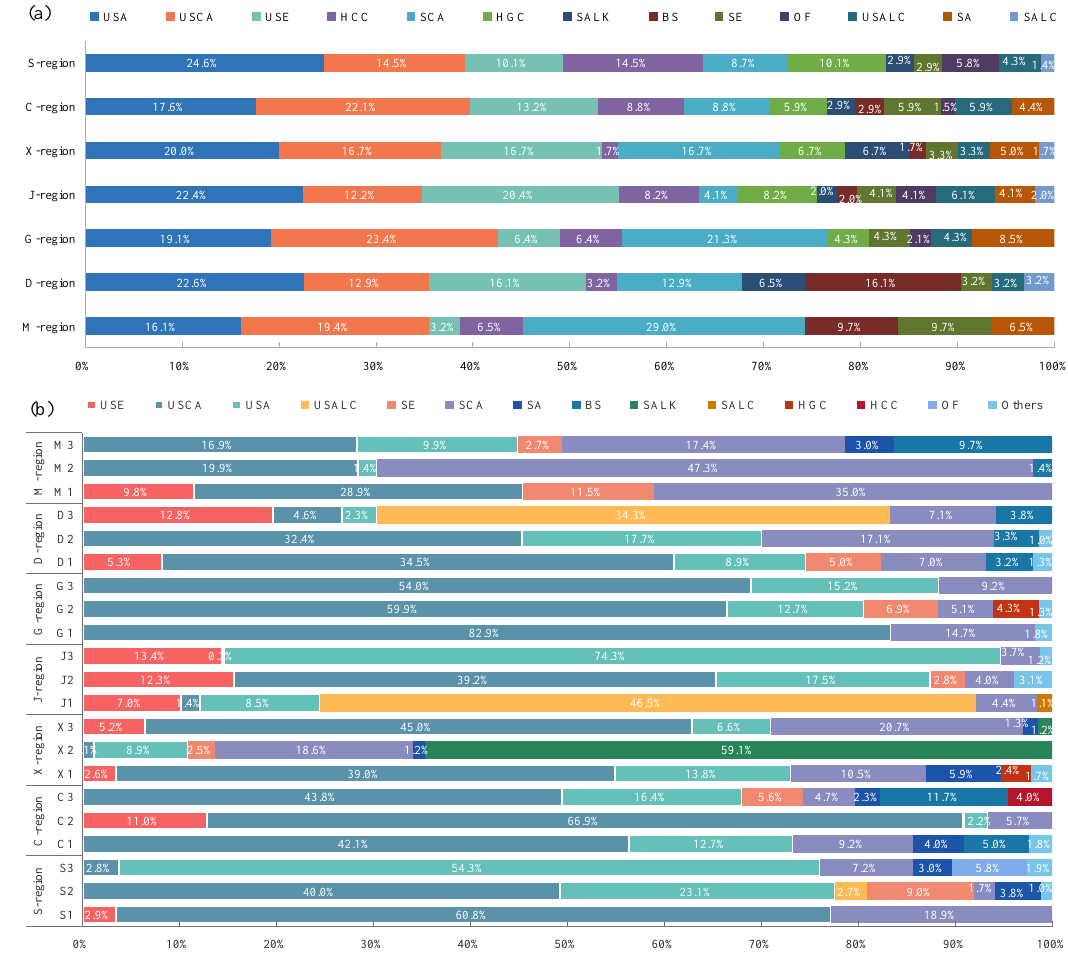
Figure 4. VOCs 1 in COF condensates of the 7 regions ( a ) species composition; ( b ) relative content).